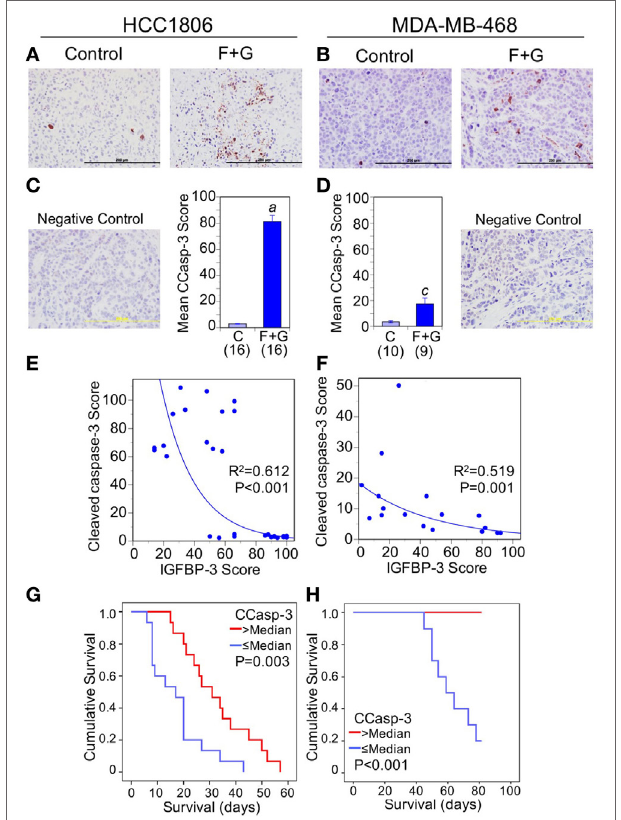
FigUre 5 | The relationship between tumor cleaved caspase-3 (CCasp-3) and mouse survival. (a,B) Representative CCasp-3 staining of each tumor type from control mice and mice treated with fingolimod + gefitinib (F + G). (c,D) Quantitation of immunohistochemistry (IHC) scores for CCasp-3 in control and combination-treated mice. For HCC1806 (c) and MDA-MB-468 (D) tumors, mean scores ± SEM are shown, numbers of mice in parentheses. Comparison with controls (2-sided t -test): ( a ) P < 0.001; ( c ) P = 0.006. Also shown are IgG isotype negative staining controls for both tumor types. (e,F) Nuclear insulin-like growth factor binding protein-3 scores are negatively correlated with CCasp-3 scores for both HCC1806 (e) and MDA-MB-468 (F) tumors. Exponential regression lines are shown with R 2 and P values indicated. (g,h) Kaplan–Meier survival curves compare the effect of tumor CCasp-3 IHC scores > or ≤ the median value on survival of mice bearing HCC1806 (g) or MDA-MB-468 (h) xenograft tumors. For ethical reasons mouse survival is defined as tumor size below 1,000 mm 3 . For HCC1806, n ( > median) = 15; n ( ≤ median) = 15. For MDA-MB-468, n ( > median) = 9; n ( ≤ median) = 10.